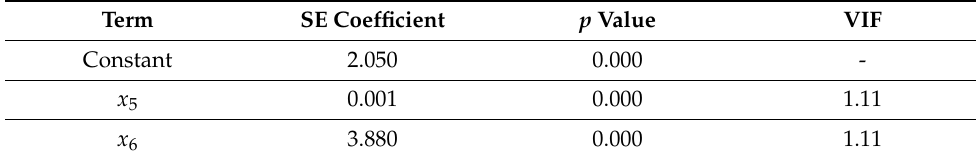
Table 6. Coefficient analysis of failure mode prediction